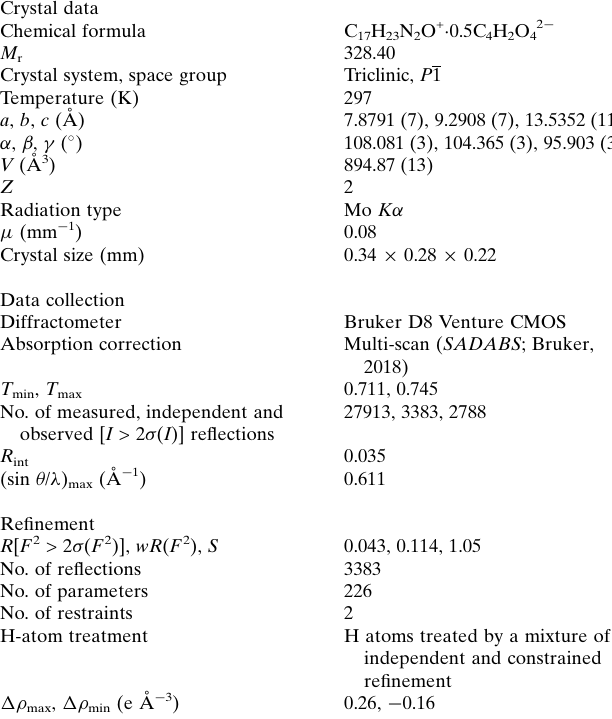
Table 2 Experimental details. Crystal data Chemical